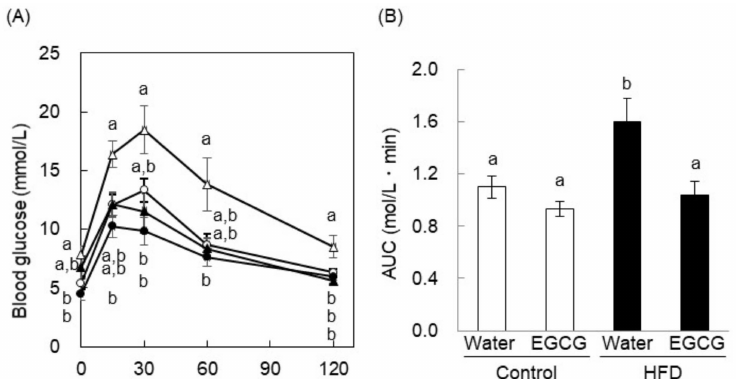
Figure 8. EGCG ameliorated glucose intolerance in high-fat diet-induced obese and diabetic mice. ( A ) After 13 weeks of high-fat diet (HFD) feeding, mice were orally administered glucose (2 g / kg body weight) after 18 h of fasting, and their blood glucose concentrations were measured 0, 30, 60, and 120 min later. Here, (cid:35) body weight was orally administered 60 min before glucose administration); means ± SE ( n = 4). Values sharing the same letters were not significantly di ff erent